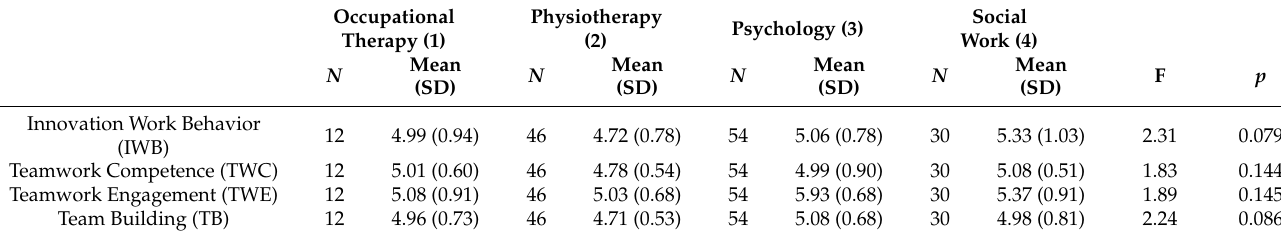
Table 2. One-way ANOVA by group degree.